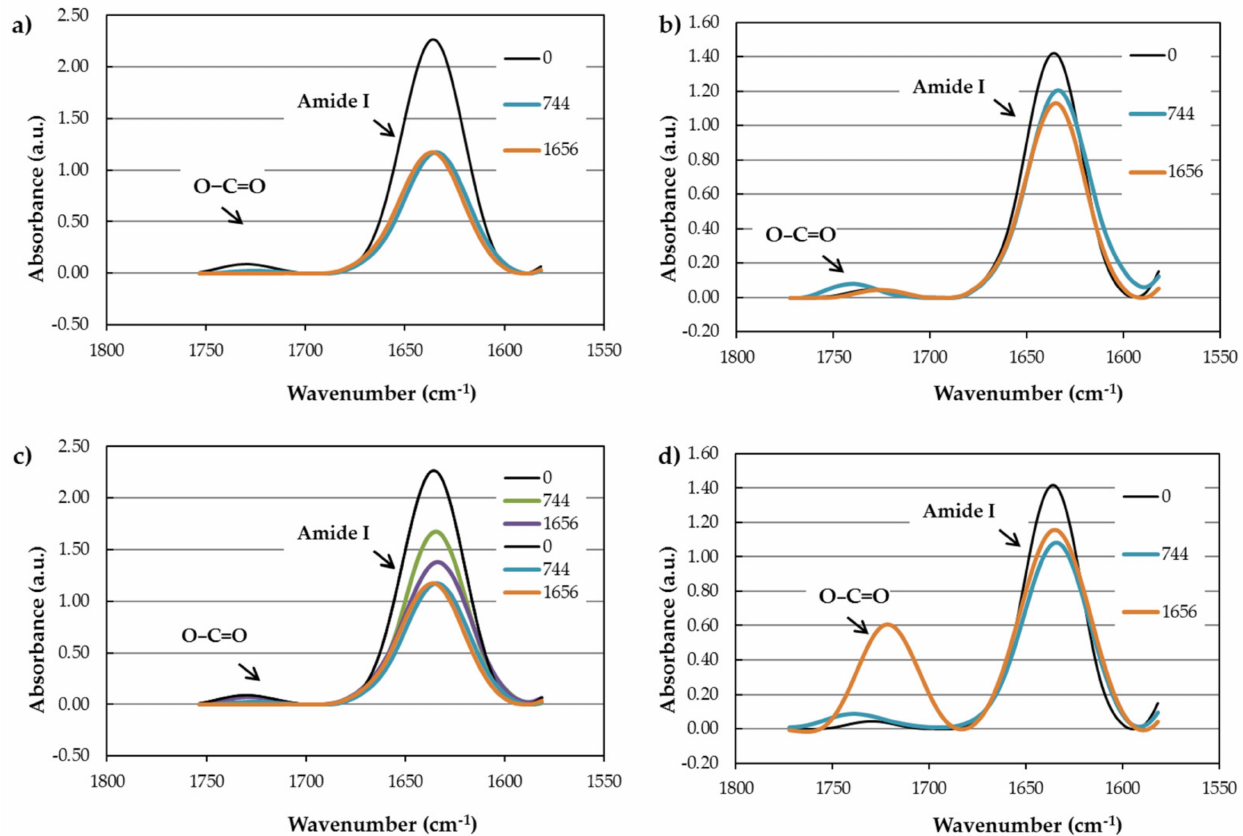
Figure 17. Comparison of amide I band between PA11 and PA12 after water and moisture absorption: ( a ) PA11-W;